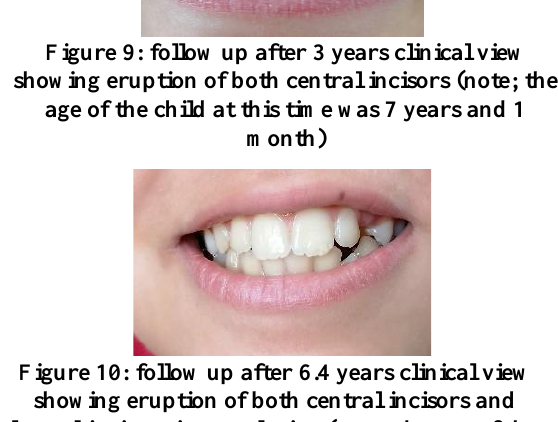
Figure 10: follow up after 6.4 years clinical view showing eruption of both central incisors and lateral incisors into occlusion (note; the age of the child at this time was 10 years and 9